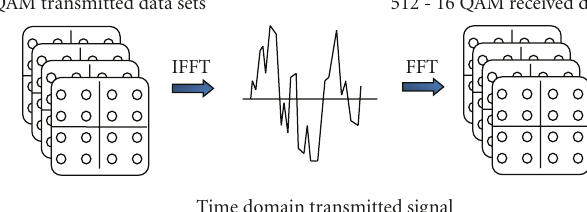
Figure 7: An illustration of the data transmission process.